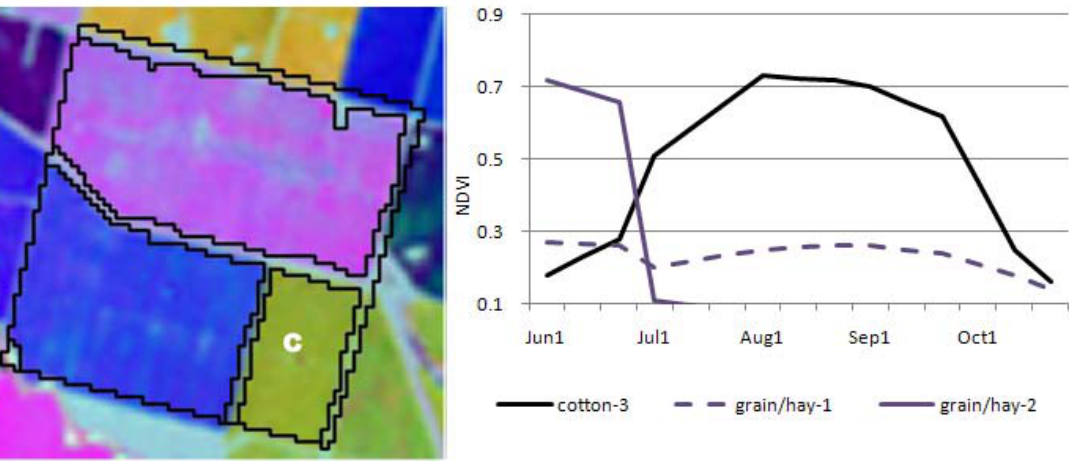
Figure 5. Landsat time series color composite image (left, PCA123) and NDVI time series plots (right) for all crop fields within Section 17S17E01. Paraquat was applied to one cotton field. Only one field had NDVI time series values similar to cotton (identified as a white “C” on the image to the left and black line in the graph on the right). The specific field where paraquat was applied was correctly identified in this example.